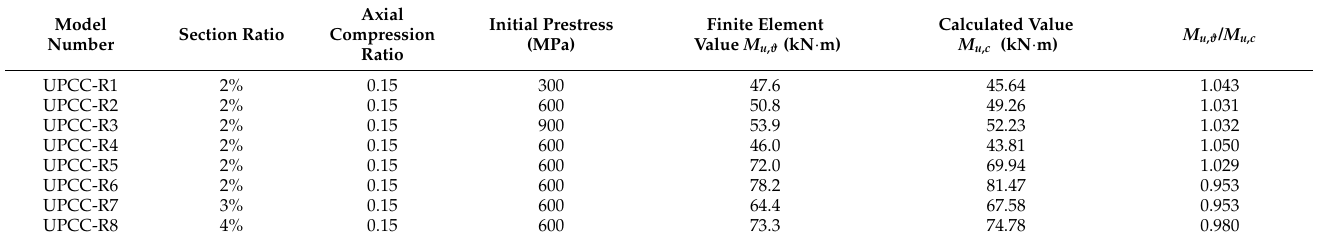
Table 14. Comparison between simulated values and calculated values of flexural bearing